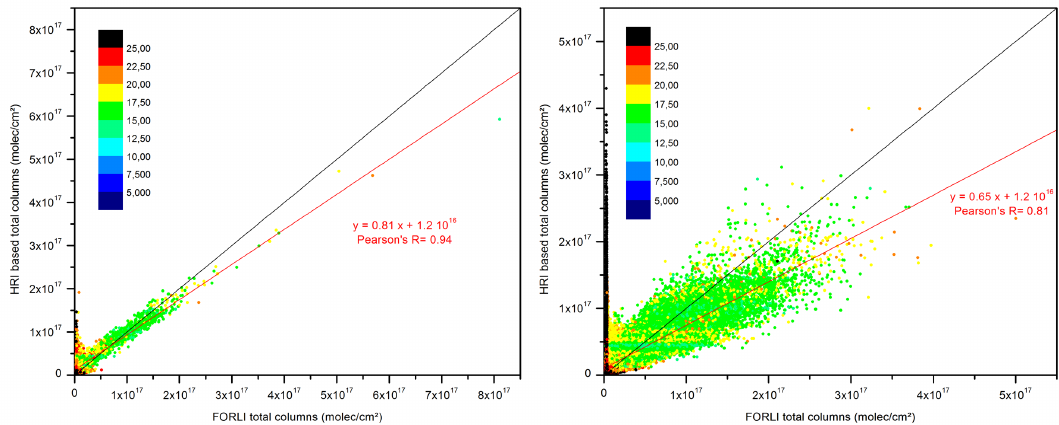
Fig. 9. NH 3 total columns in moleccm − 2 retrieved in this work from the HRI retrieval scheme ( y axis) versus those retrieved by FORLI ( x axis) for 15 August 2010 (left panel) and over the entire year 2011 (right panel). The colors refer to the error calculated with the HRI retrieval scheme. The black line represents the 1:1 slope and the red line the linear regression weighted by the HRI retrieval errors. The Pearson’s r coefficient, the values of slope and intercept from the linear regression are also